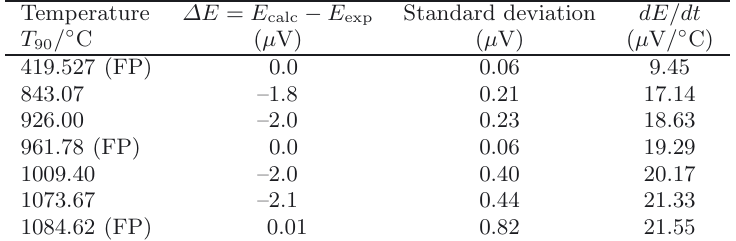
Table 2. Experimental values for temperature, t 90 , thermoelectric voltage, and related standard deviation. A freezing point is denoted as FP.